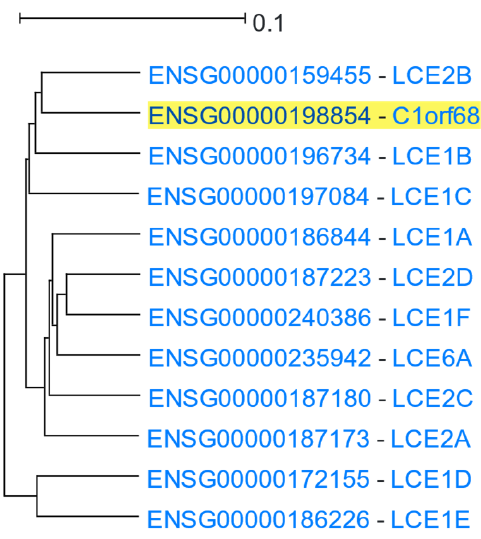
Figure 8. HGCA2.0 C1orf68 5 internal node coexpression clade. Table 7. Selected top gene term enrichments of the coexpressed genes to C1orf68 in HGCA2.0.